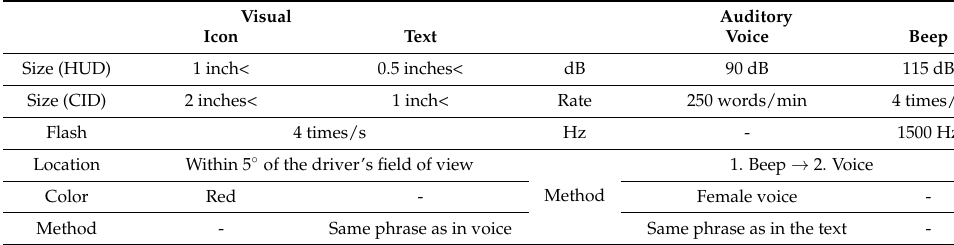
Table 1. Alarm method for drowsy drivers.